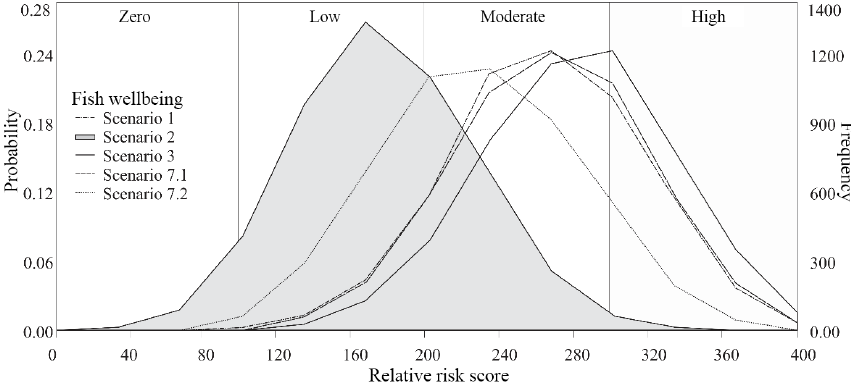
Figure 9. Probability profiles generated during a PROBFLO assessment, overlaid onto risk rank range (Zero, Low, Moderate and High) to describe the relative risk of the multiple sources and stressors, including altered flows, associated with alternative management scenarios considered in the Lesotho case study to the fish wellbeing